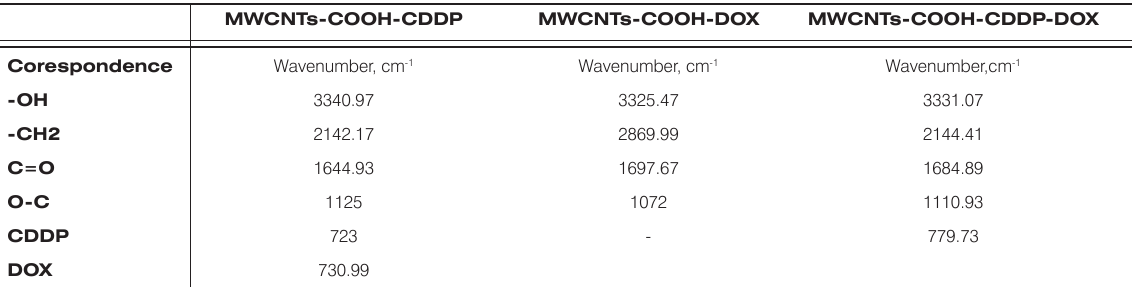
Table 1. The comparison of the structure of functionalised carbon nanotubes with various therapeutic